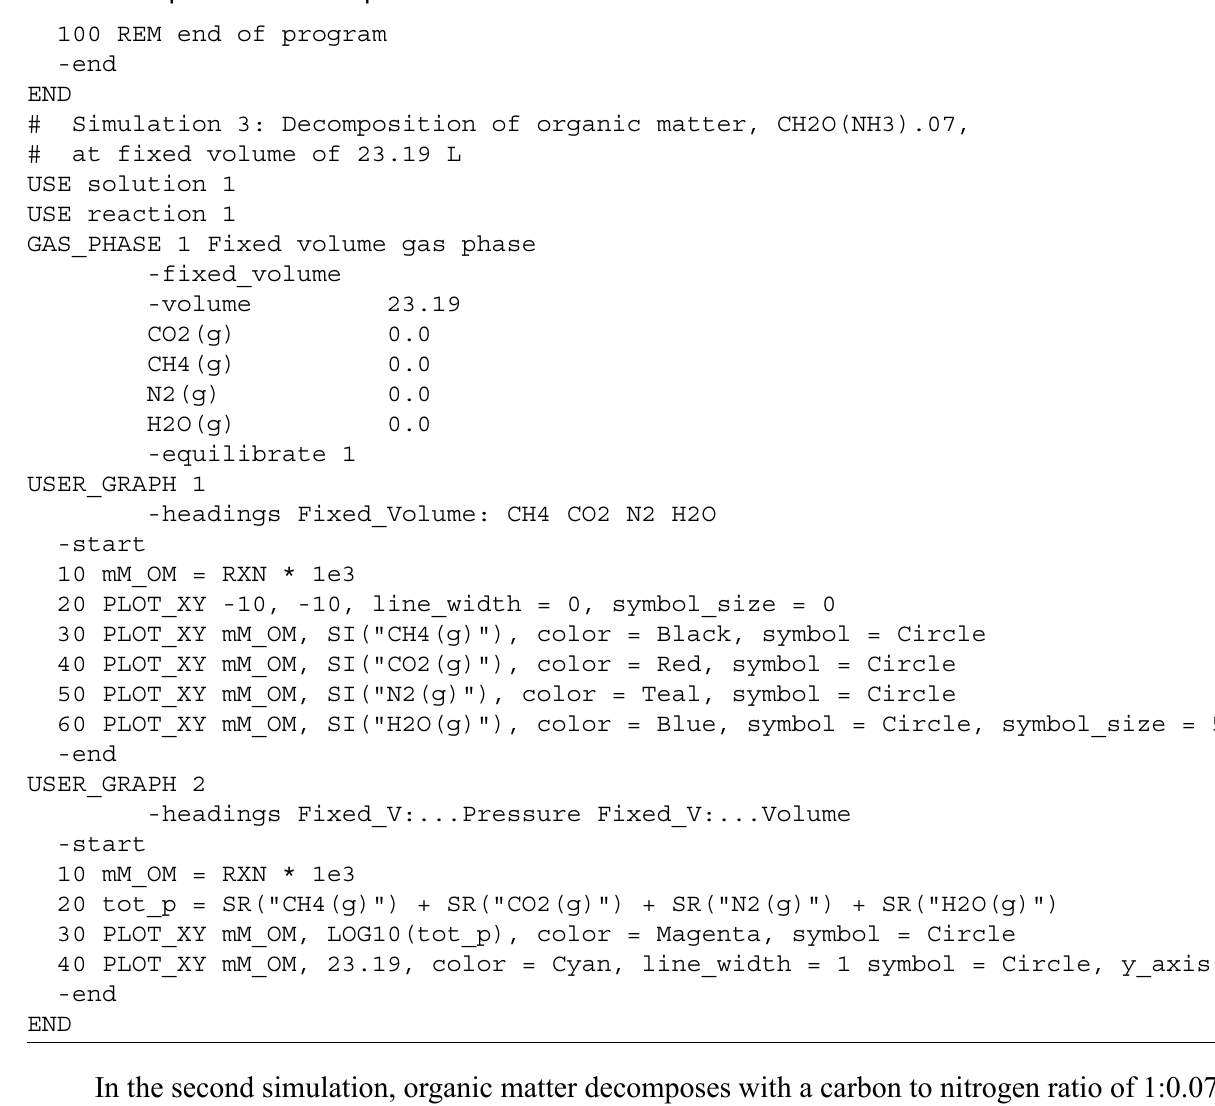
Table 26. Input file for example